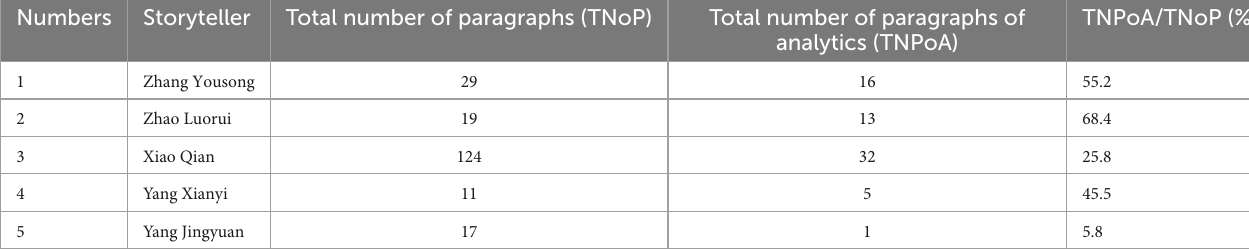
TABLE 4 Percentage of analytics in each